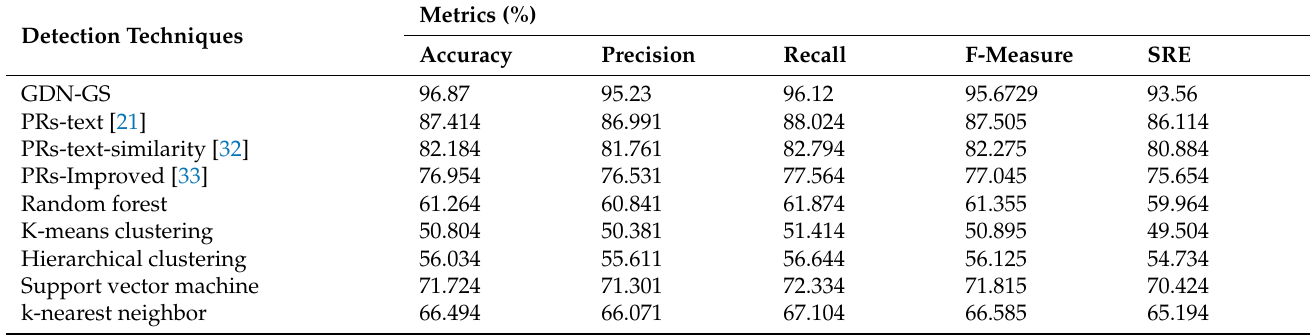
Table 6. Comparative analysis with DupPR-complementary